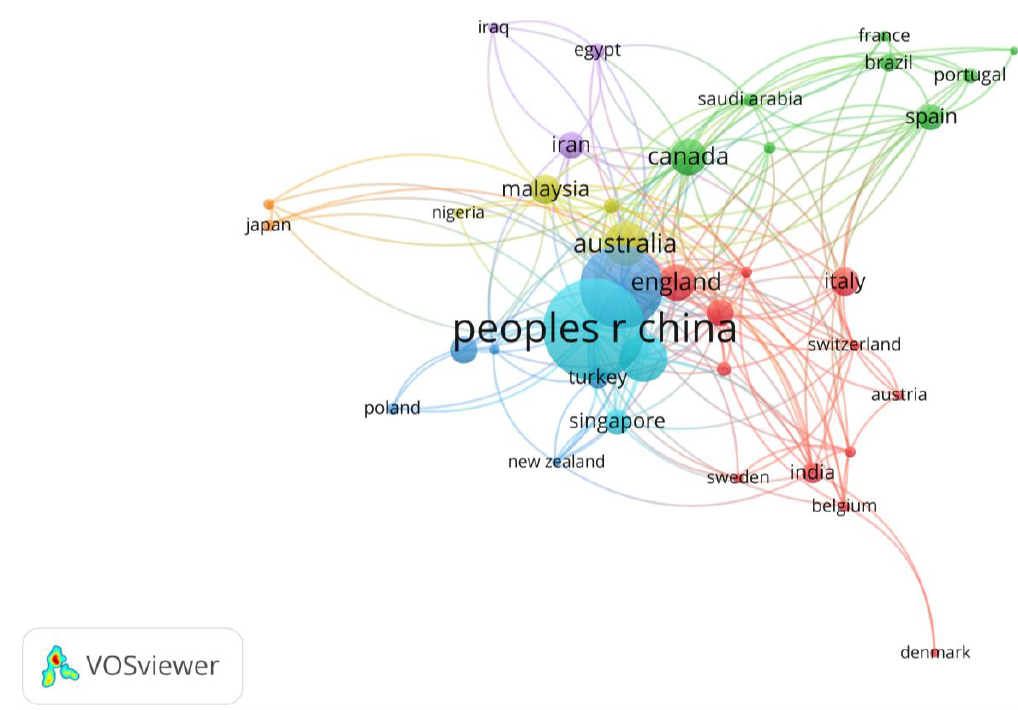
Figure 5. Bibliographic coupling for countries. Table 1. The number of documents and citations of the top 20 countries.